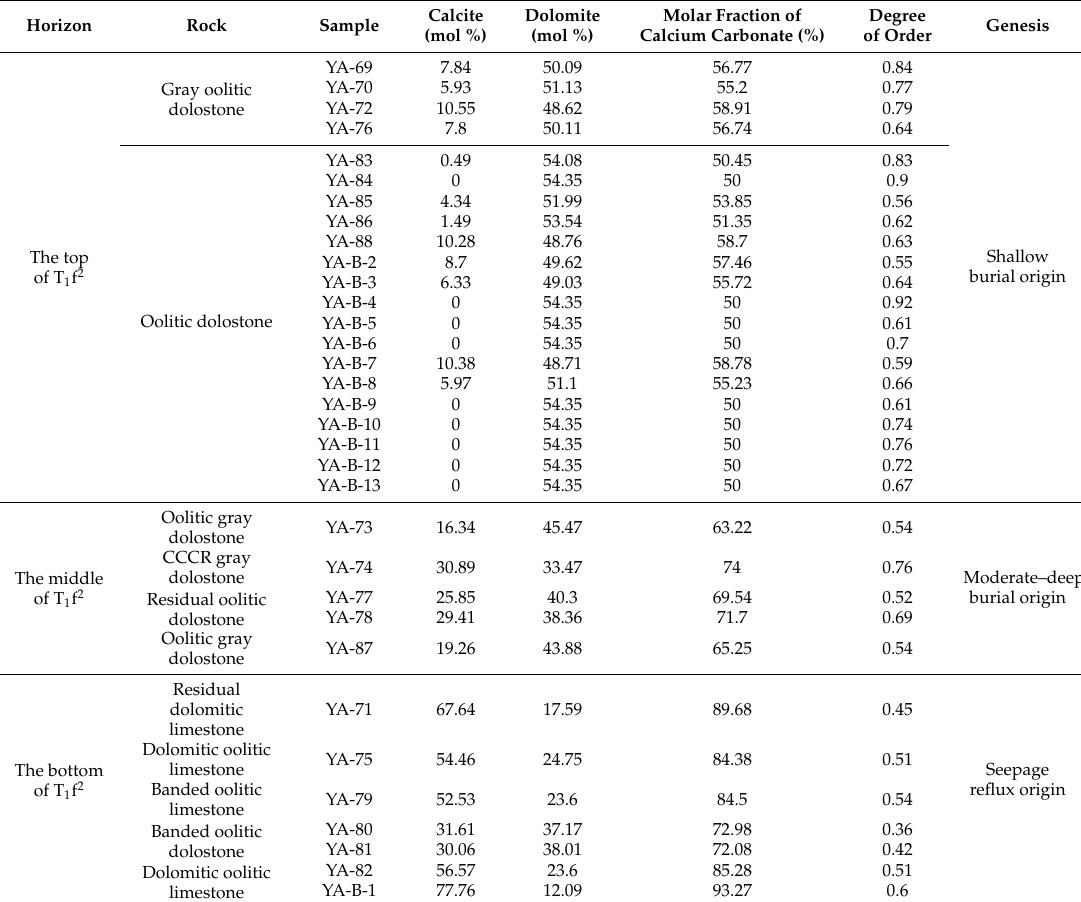
Table 1. X-ray diffraction (XRD) data for different dolostone types from the Yudongzi outcrop in the Feixianguan